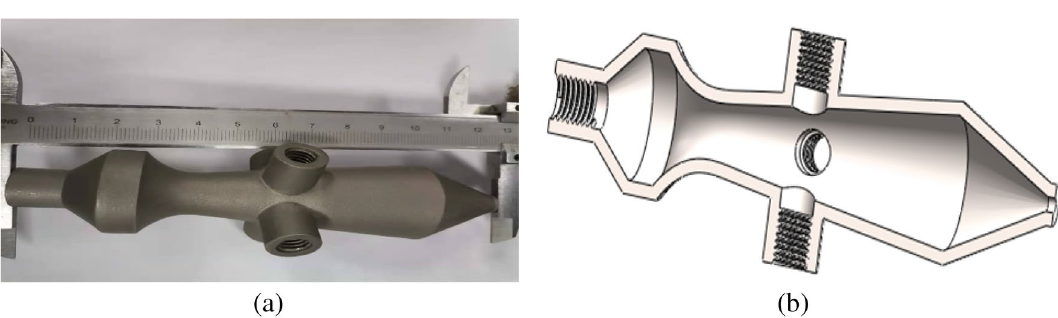
Figure 4. Internal cloud map of supersonic nozzle. ( a ) Transverse central axis. ( b ) Longitudinal axis velocity.